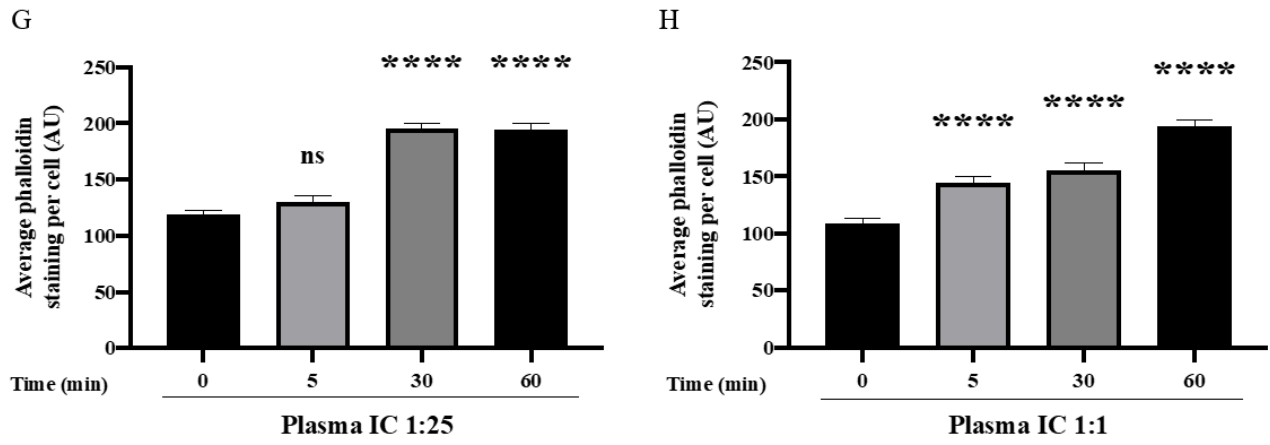
Figure 4. ABO mismatched serum and IC decrease cell surface VE-cadherin and induce actin stress fiber formation in HPAEC. Type O HPAEC were plated on coverslips and treated with ( A , B ) concentrated O serum, concentrated A serum, ( C – E ) serum-derived IC 1:1 with media, or ( F – H ) plasma-derived IC 1:25 or 1:1 with media for the indicated time points. Cells were stained with anti-VE-cadherin antibody (green) to mark adherens functions (AJs), Phalloidin-594 (red) to stain actin stress fibers, and DAPI (blue) to label nuclei. ( B , E , G , H ) Mean fluorescence intensity of actin stress fibers (phalloidin staining) per cell was determined. Values are reported in arbitrary units (AU) and analyzed by ANOVA. p -values as follows: ** p < 0.005; **** p < 0.0001; ns = not significant.